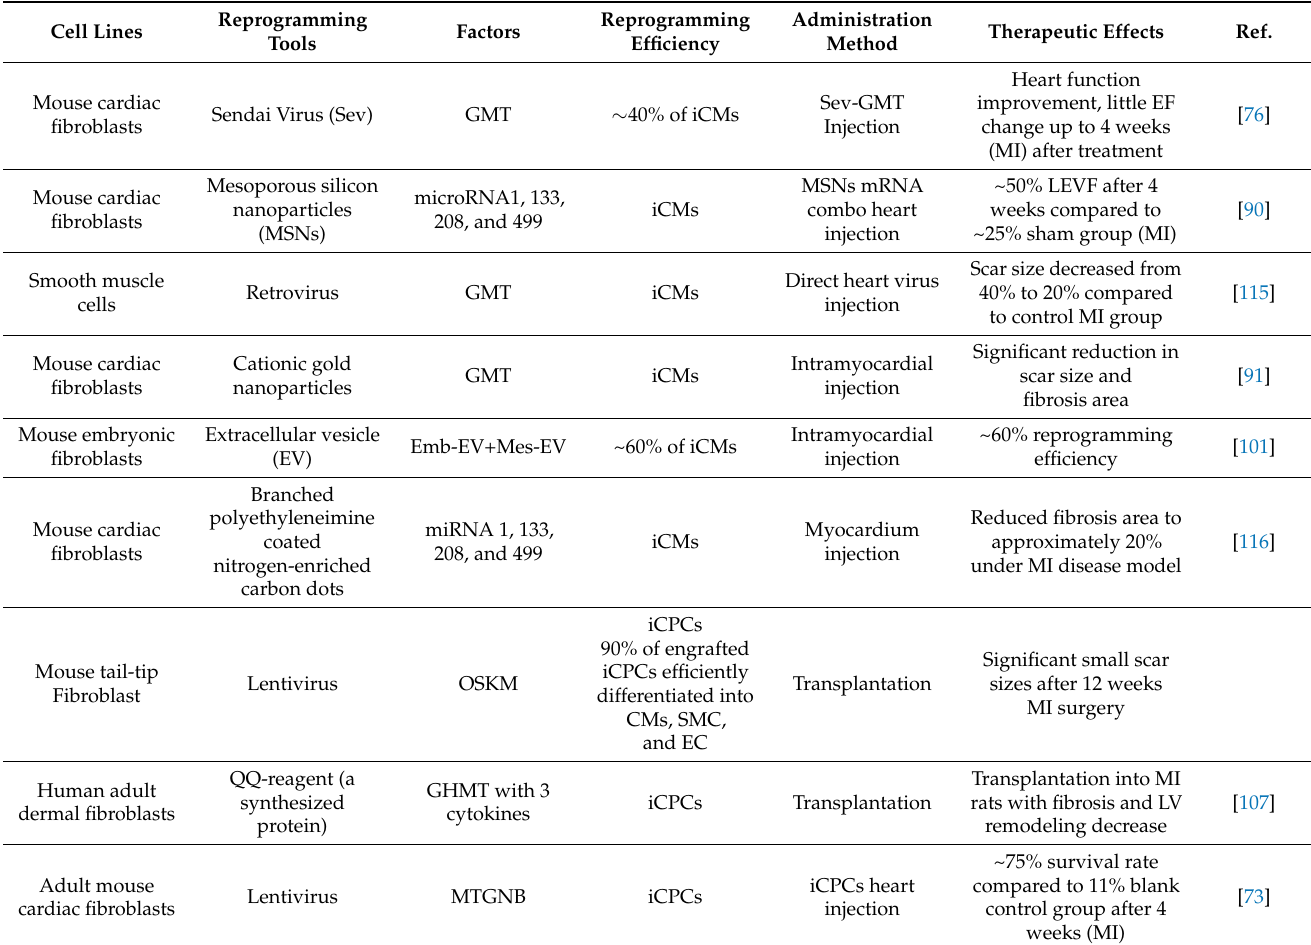
Table 1. Summary of achieved in vivo studies for using direct reprogramming techniques for cardio- vascular disease